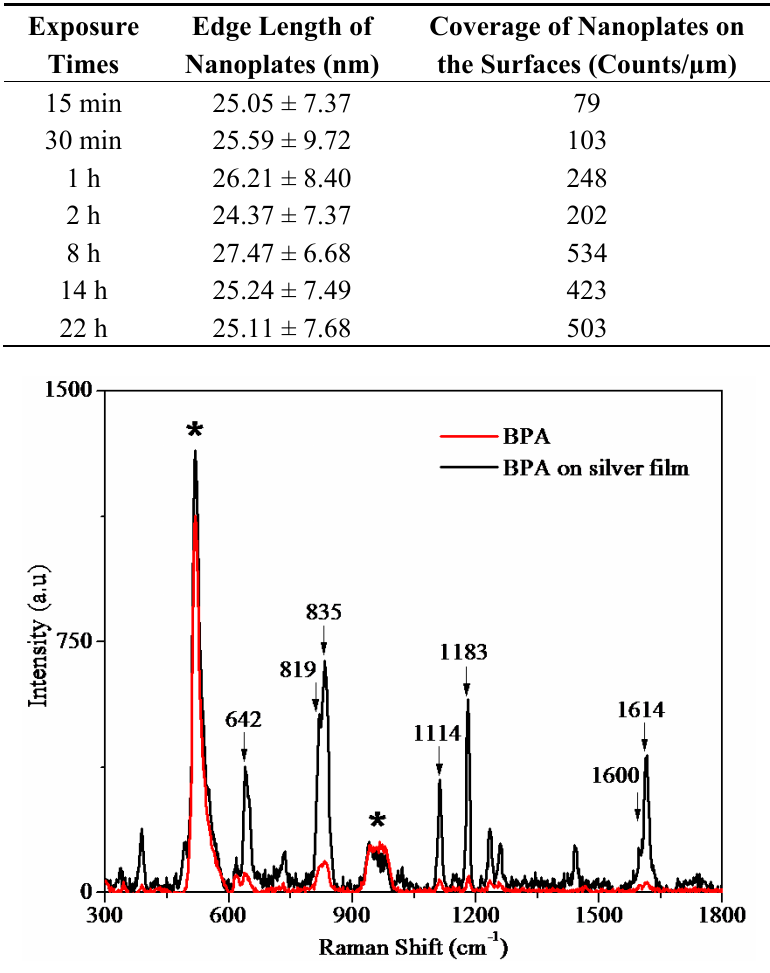
Figure 7. The SERS spectrum of BPA on the silver nanoplate film (formed after 2 h exposure time) and Raman of BPA absorbed on a clean silicon surface. * are labels for the silicon